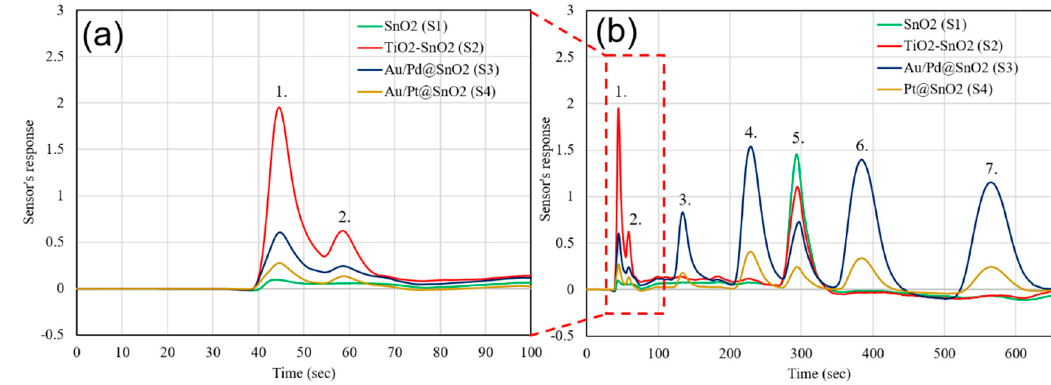
Figure 5. Gas chromatogram of Mix. 1: ( a ) Zoomed image of light compounds and ( b ) the full gas chromatogram. (1. H 2 S 100 ppb, 2. Ethyl-Mercaptan 50 ppb, 3. Benzene 10 ppb, 4. Toluene 10 ppb, 5. Water, 6. Ethylbenzene 10 ppb, 7. O-Xylene 10 ppb).